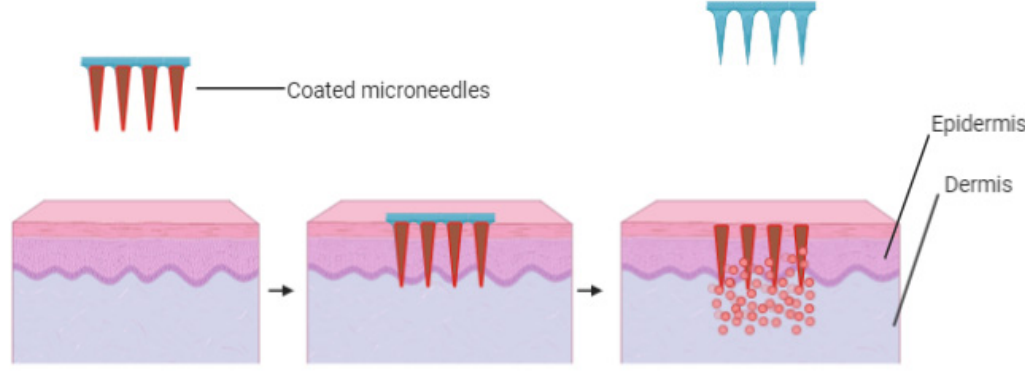
Figure 5. Illustration of “poke and release” using coated microneedles